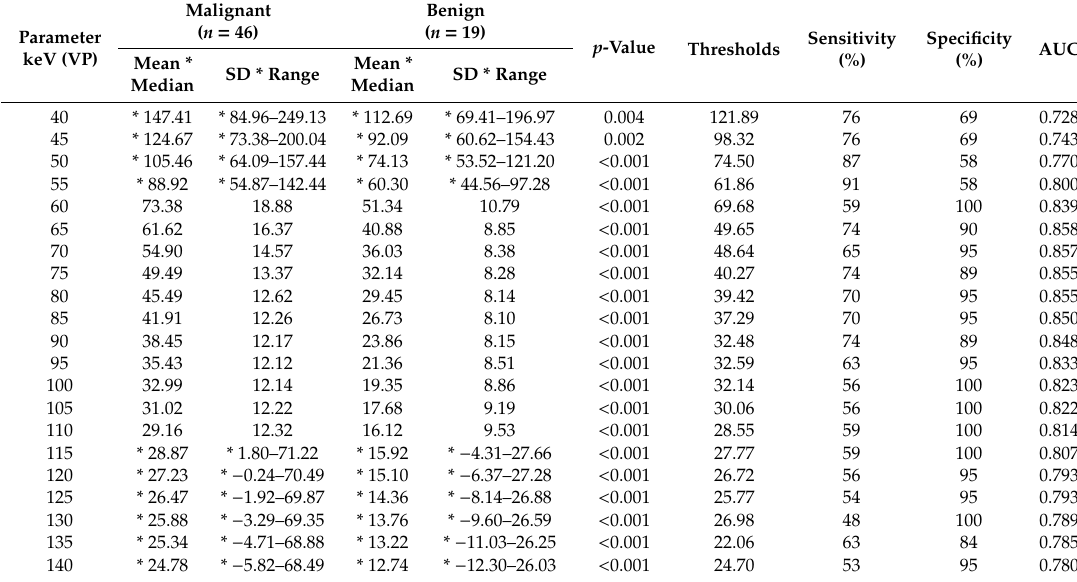
TableA2. Analysisofdifferencesbetweenmalignantandbenignnodules. Student’s t andMann–Whitney U * analyses. Thresholds, sensitivity, specificity and AUCs are based on the ROC curves for each keV energy level in